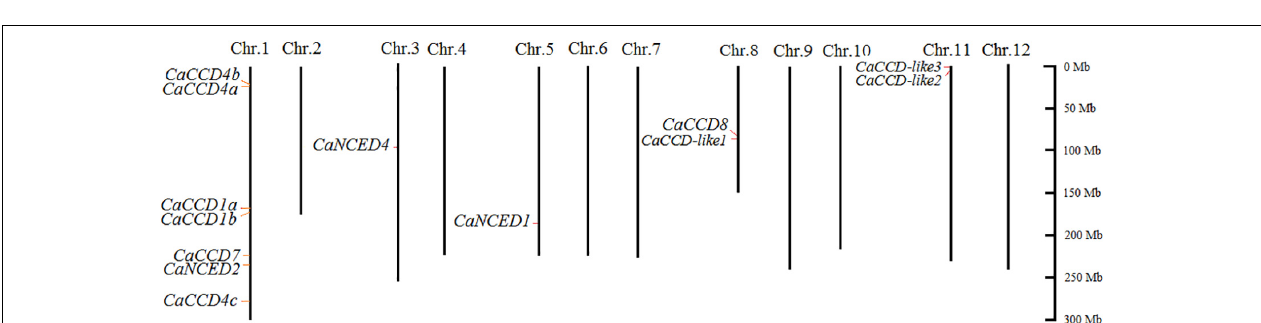
FIGURE 1 | Evolutionary origin of carotenoid cleavage oxygenase (CCO) proteins in plant species. The unrooted tree was constructed using the neighbor-joining (NJ) method in MEGA5.0 software. The parameters were 1,000 bootstraps. The CCO proteins were classified into two groups: I and II. The former was subdivided into CCD7 and CCD8, while the latter was subdivided into CCD1, CCD-like, CCD4, and NCED.